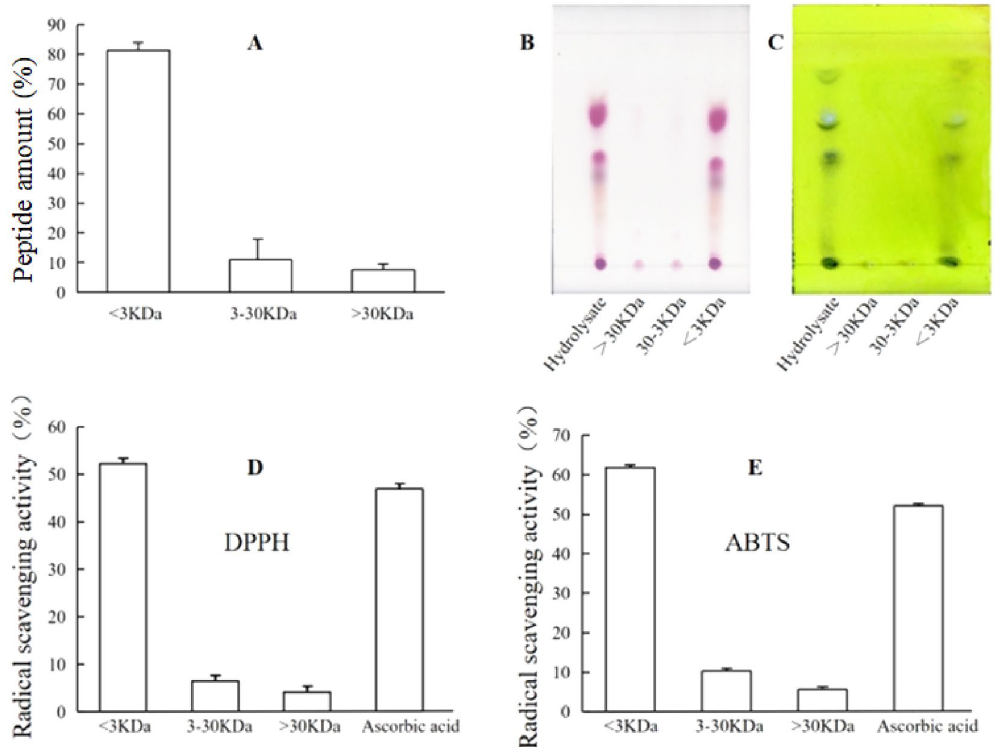
Figure 2. Peptide analysis of the three fractions of crocodile meat hydrolysates after ultrafiltration and their antioxidant activity. ( A ) Peptide amounts in the three fractions after ultrafiltration; ( B , C ) TLC analyses of the three fractions of peptides stained by ninhydrin alcohol solution(0.5%, w/v) or by BCA solution(5%, w/v in 1% copper sulfate; ( D , E ) antioxidant activities of the peptides against DPPH and